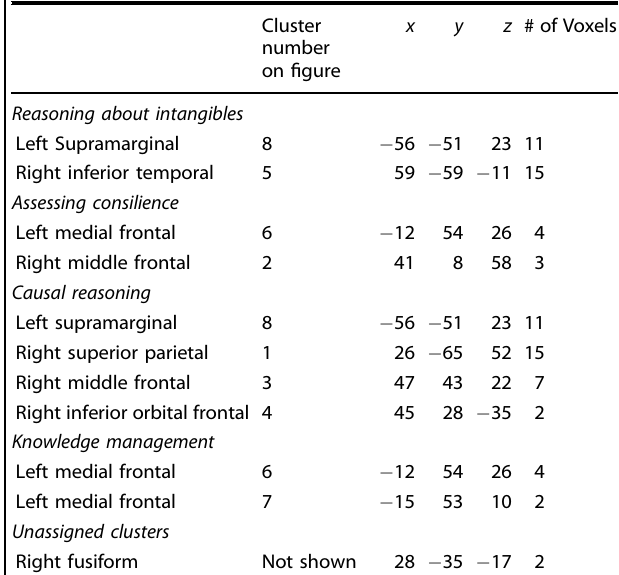
Table 2. Brain regions associated with the post-classical concepts, grouped by hypothesized cognitive process (designated in